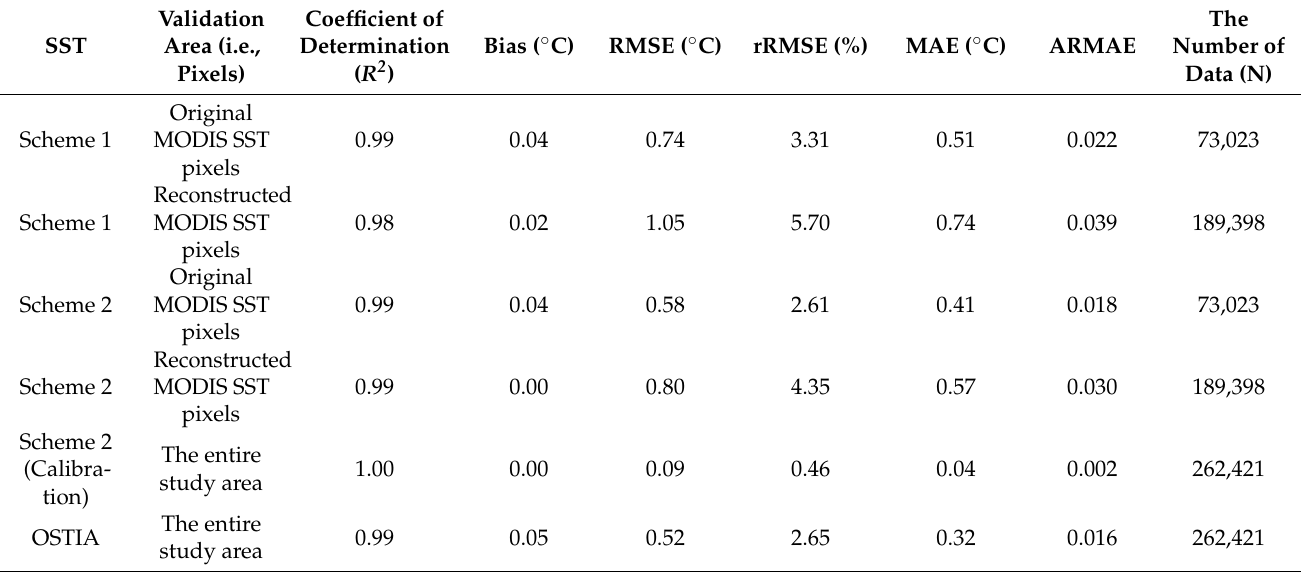
Table 6. Accuracy metrics of Leave-One-Year-Out-Cross-Validation (LOYOCV) results of schemes 1 and 2, scheme 2 calibration results, and OSTIA SST when compared to in situ